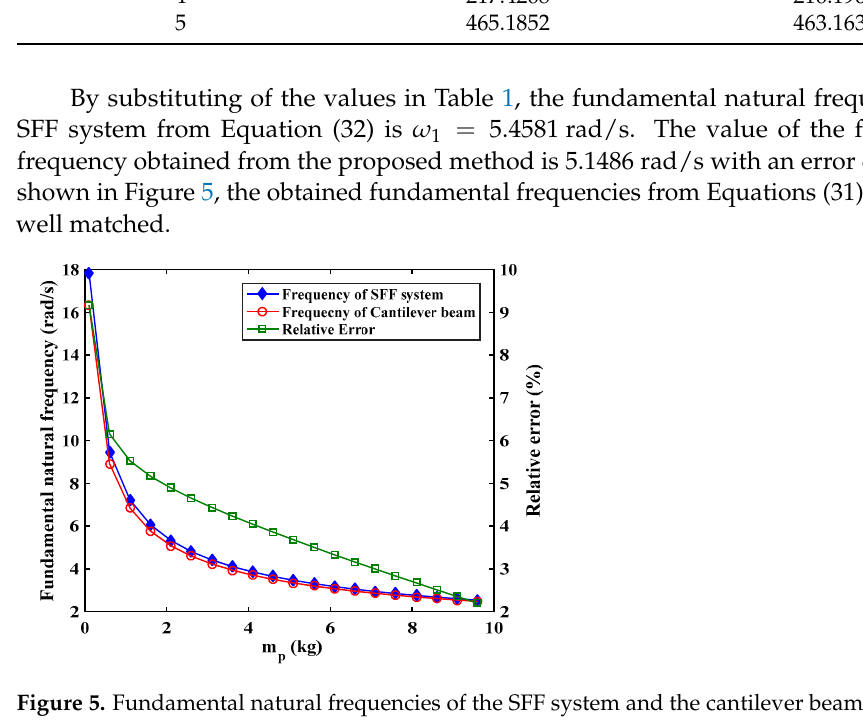
Table 2. Comparison of Natural frequencies of an SFF manipulator (unit: rad/s).